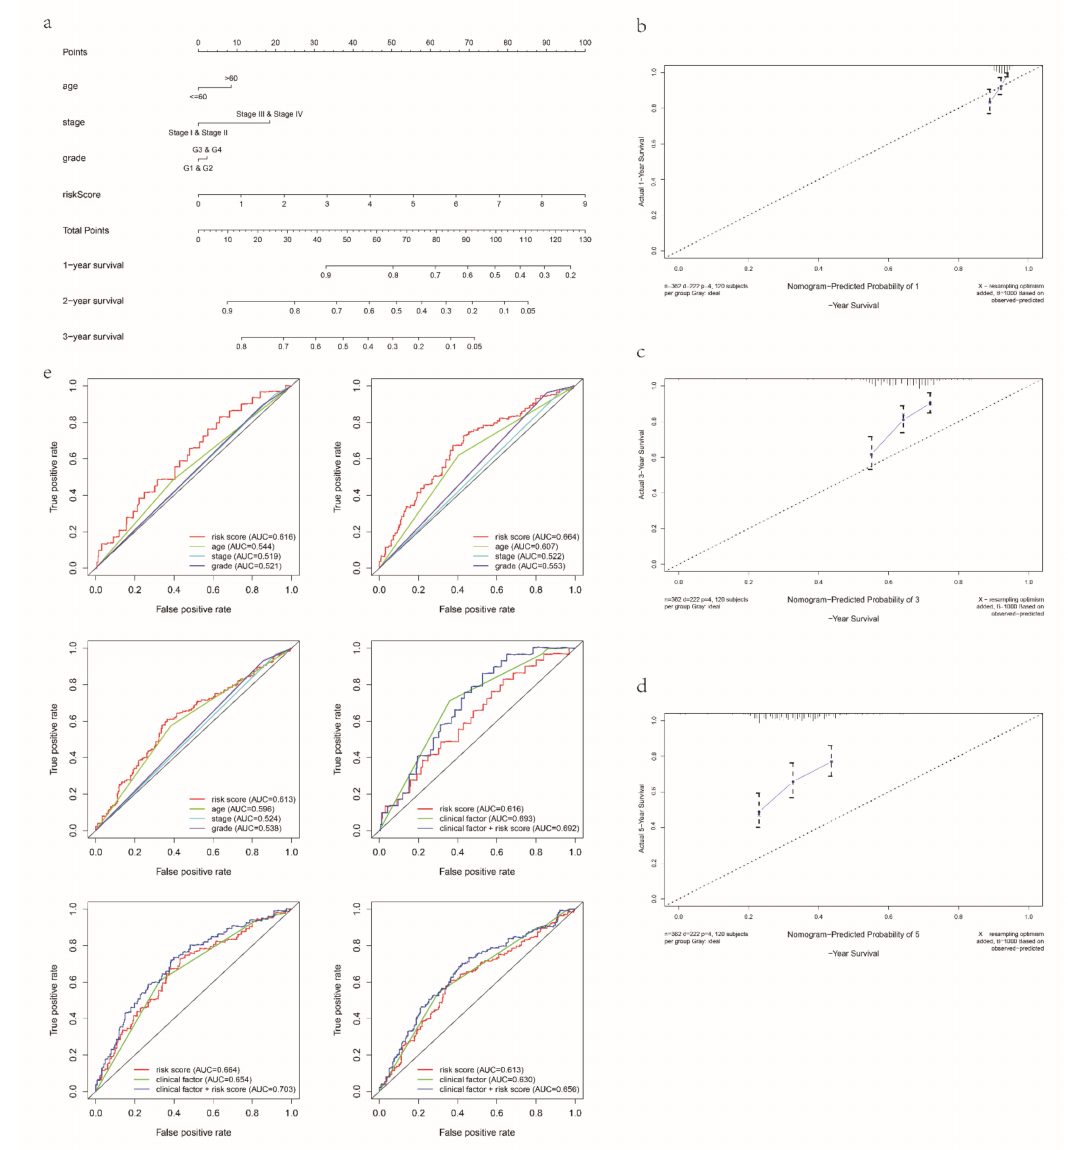
Figure 3. A nomogram for OV patients in TCGA dataset. ( a ) A nomogram for predicting the 1-, 2- and 3-year OS of OV patients. ( b – d ). Calibration curves for the prediction of 1-, 2- or 3-year overall survival of OV patients. ( e ) Time-dependent ROC curves for each parameter and the combination of independent prognostic risk factors in the TCGA dataset (for predicting 1, 2 and 3-year OS). In the TCGA-entire set, N =